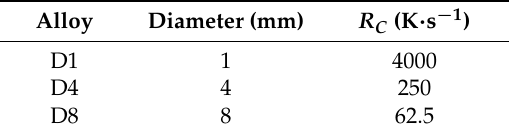
Table 1. R C values during rapid solidification (RS)